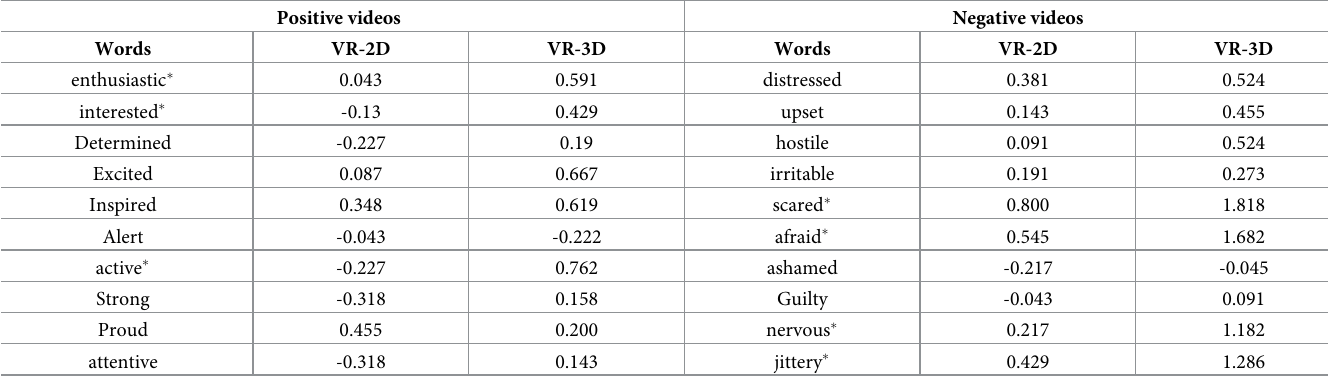
Table 4. Behavior score of PANAS emotion scale (mean).